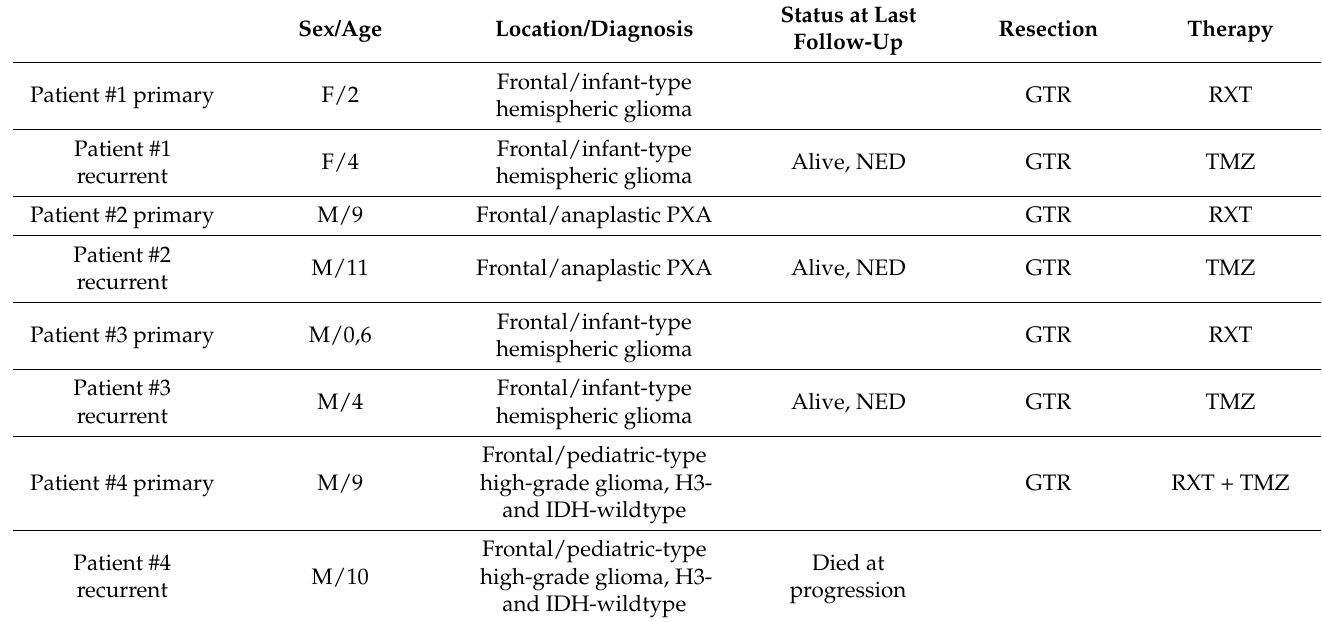
Table 1. Neuropathological and clinical features. Abbreviations: HGG: high grade glioma; PXA: xanthoastrocytoma; NED: no evidence of disease; GTR: gross total resection; RXT: radiotherapy; TMZ: